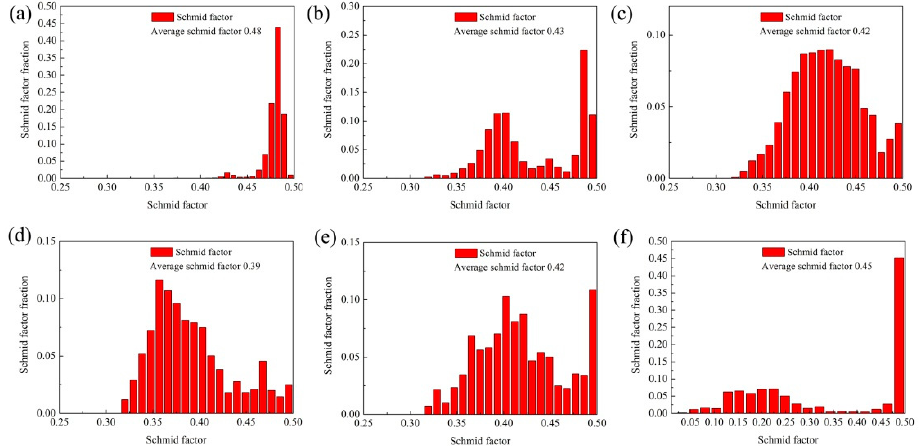
Figure 11. B 2 phase mean Schmid factors of the Ti 2 AlNb samples in {110}<111> subjected to various deformation degrees and subsequent annealing at 900 °C for 2 h: ( a ) as-rolled, ( b ) 25%, ( c ) 50%, ( d ) 60%, ( e ) 65%, and ( f ) 75%.